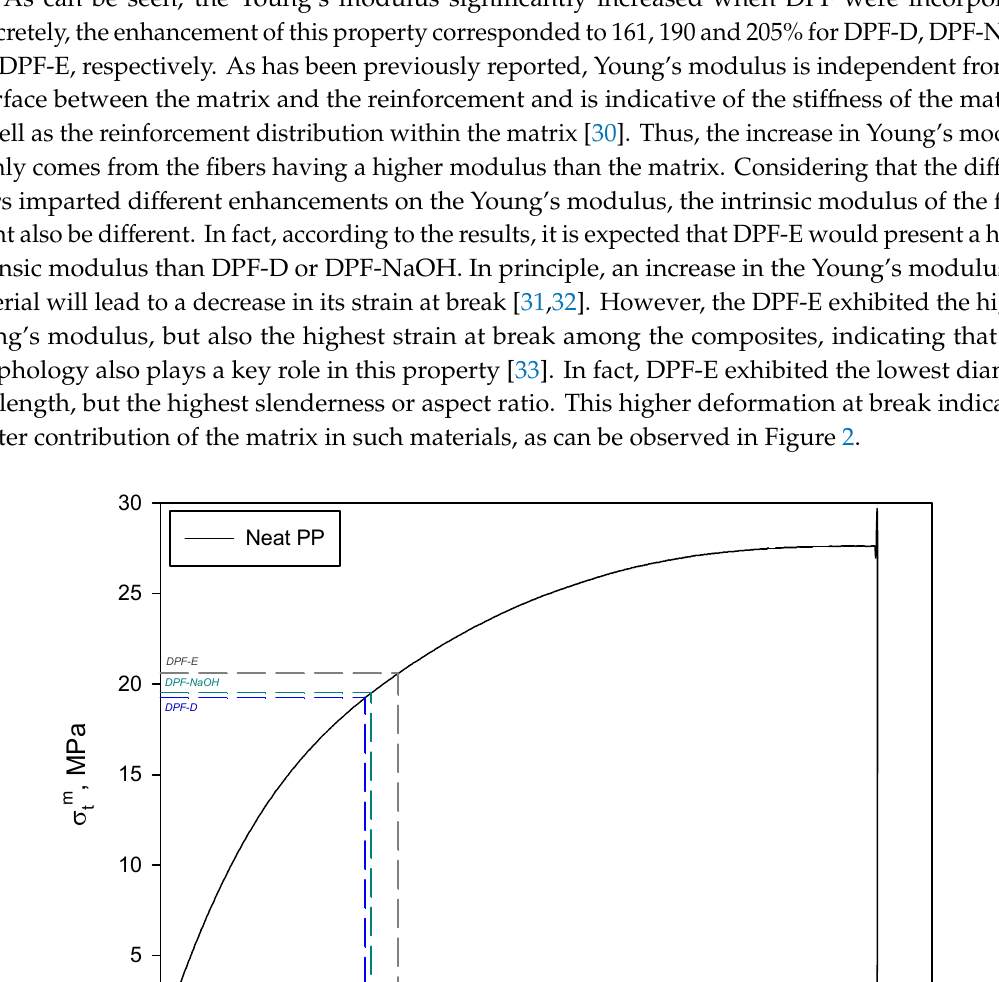
Figure 2. Determination of matrix contribution for the different composite materials.